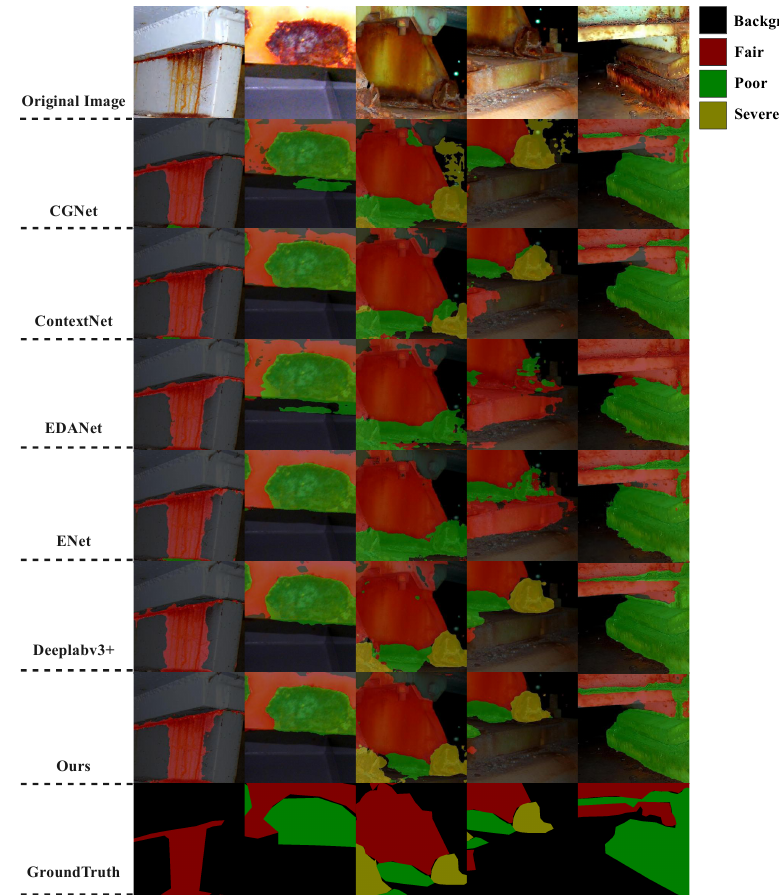
Figure 5. Visualization comparison results between our model and other SOTA methods, where Background, Fair, Poor and Severe represented the four degrees of corrosion. Best viewed in